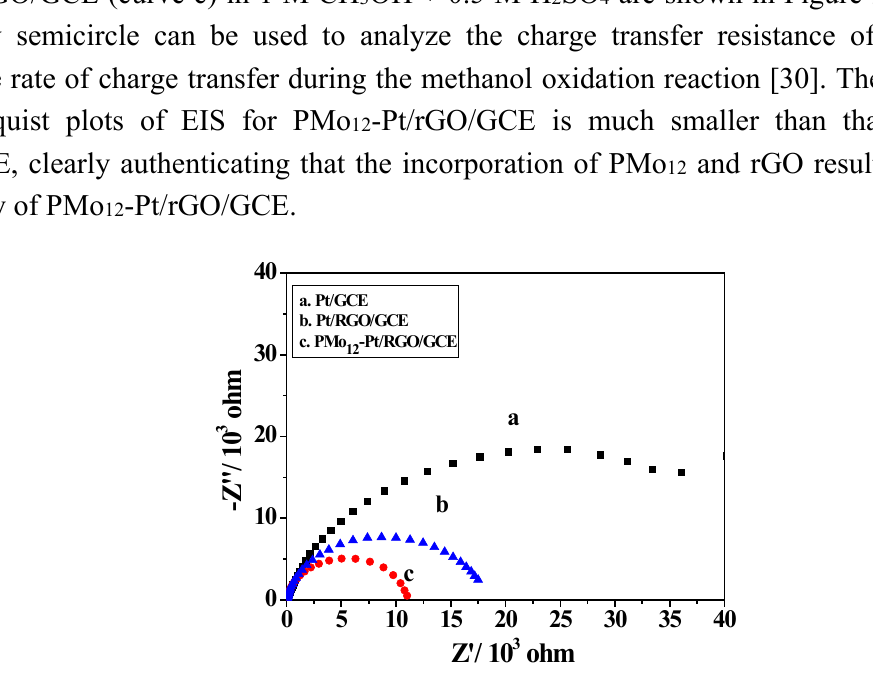
Figure 9. Nyquist plots of EIS with different films modified electrodes: ( a ) Pt/GCE; ( b ) Pt/rGO/GCE; ( c ) PMo 12 -Pt/rGO/GCE in 0.5 M H 2 SO 4 + 1 M CH 3 OH